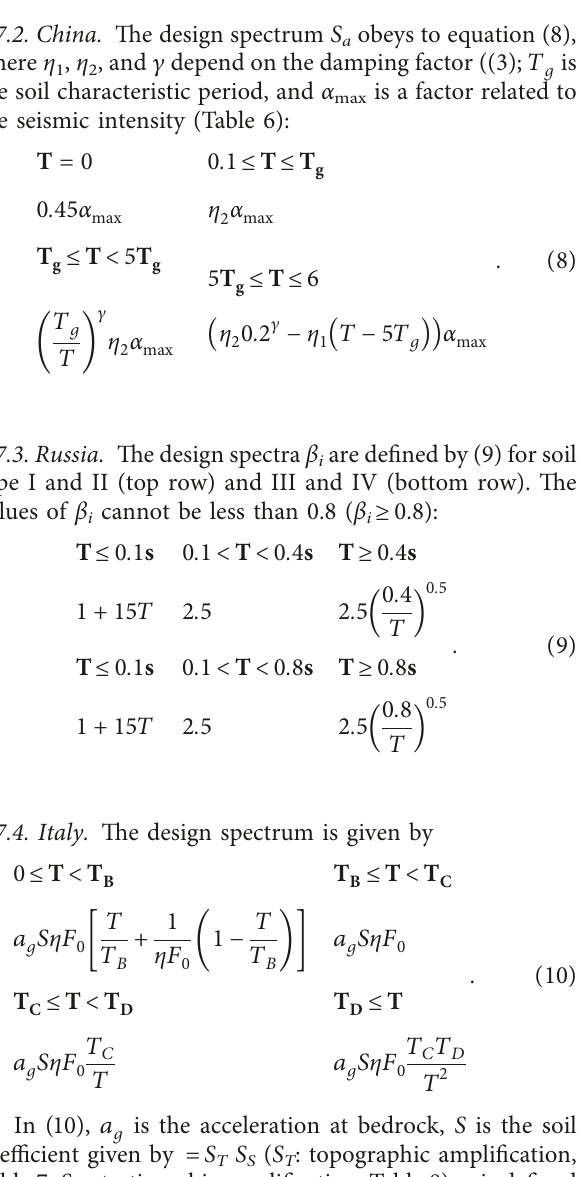
Table 7; S : stratigraphic amplification, Table 8), η is defined S